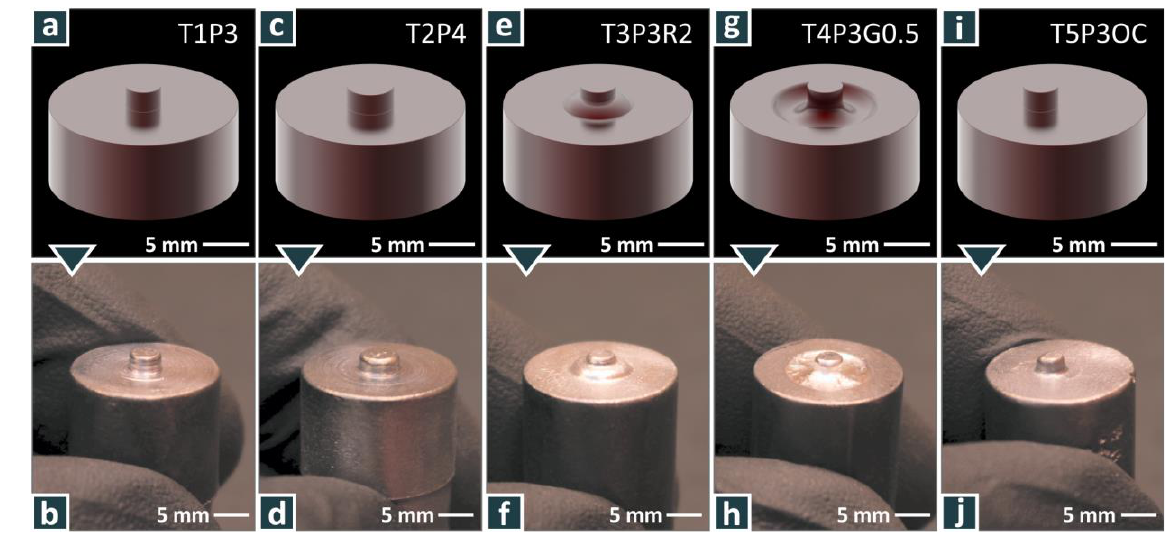
Figure 3. Five different welding tools: designs ( a , c , e , g , i ) and products ( b , d , f , h , j ).